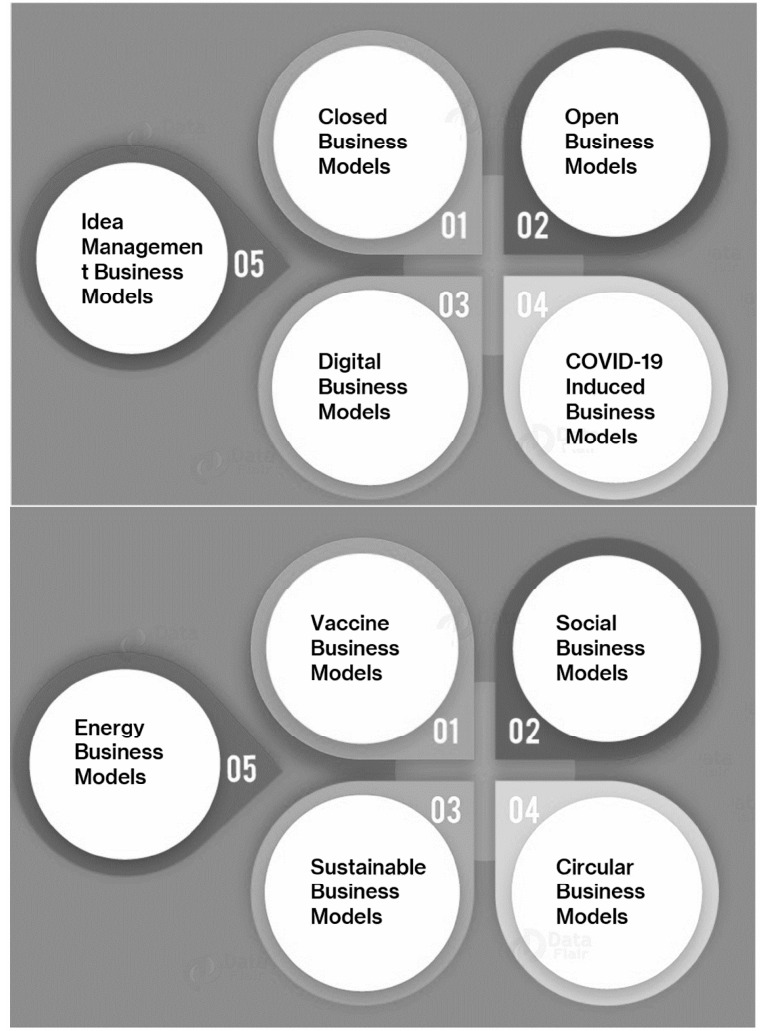
Figure 1. Business Model Families